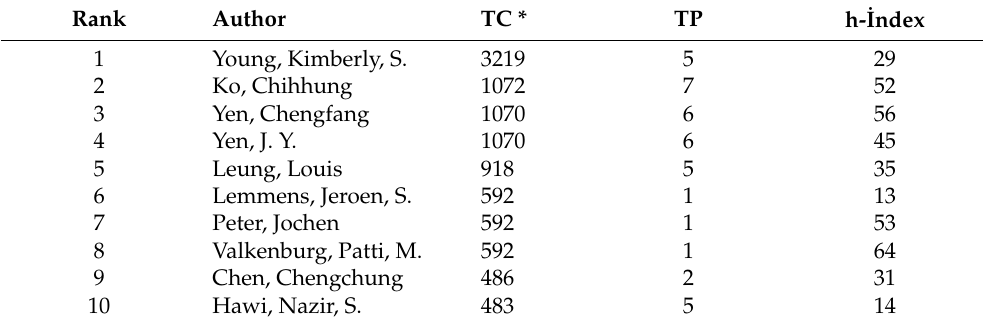
Table 2. Top 10 authors most cited in digital addiction.